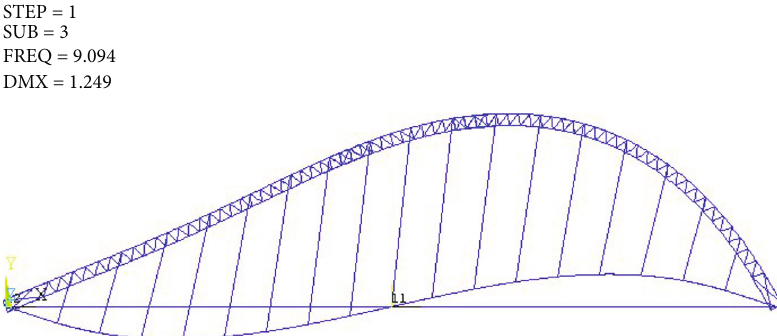
Figure 24: The third order buckling mode of arch bridge under case 7.